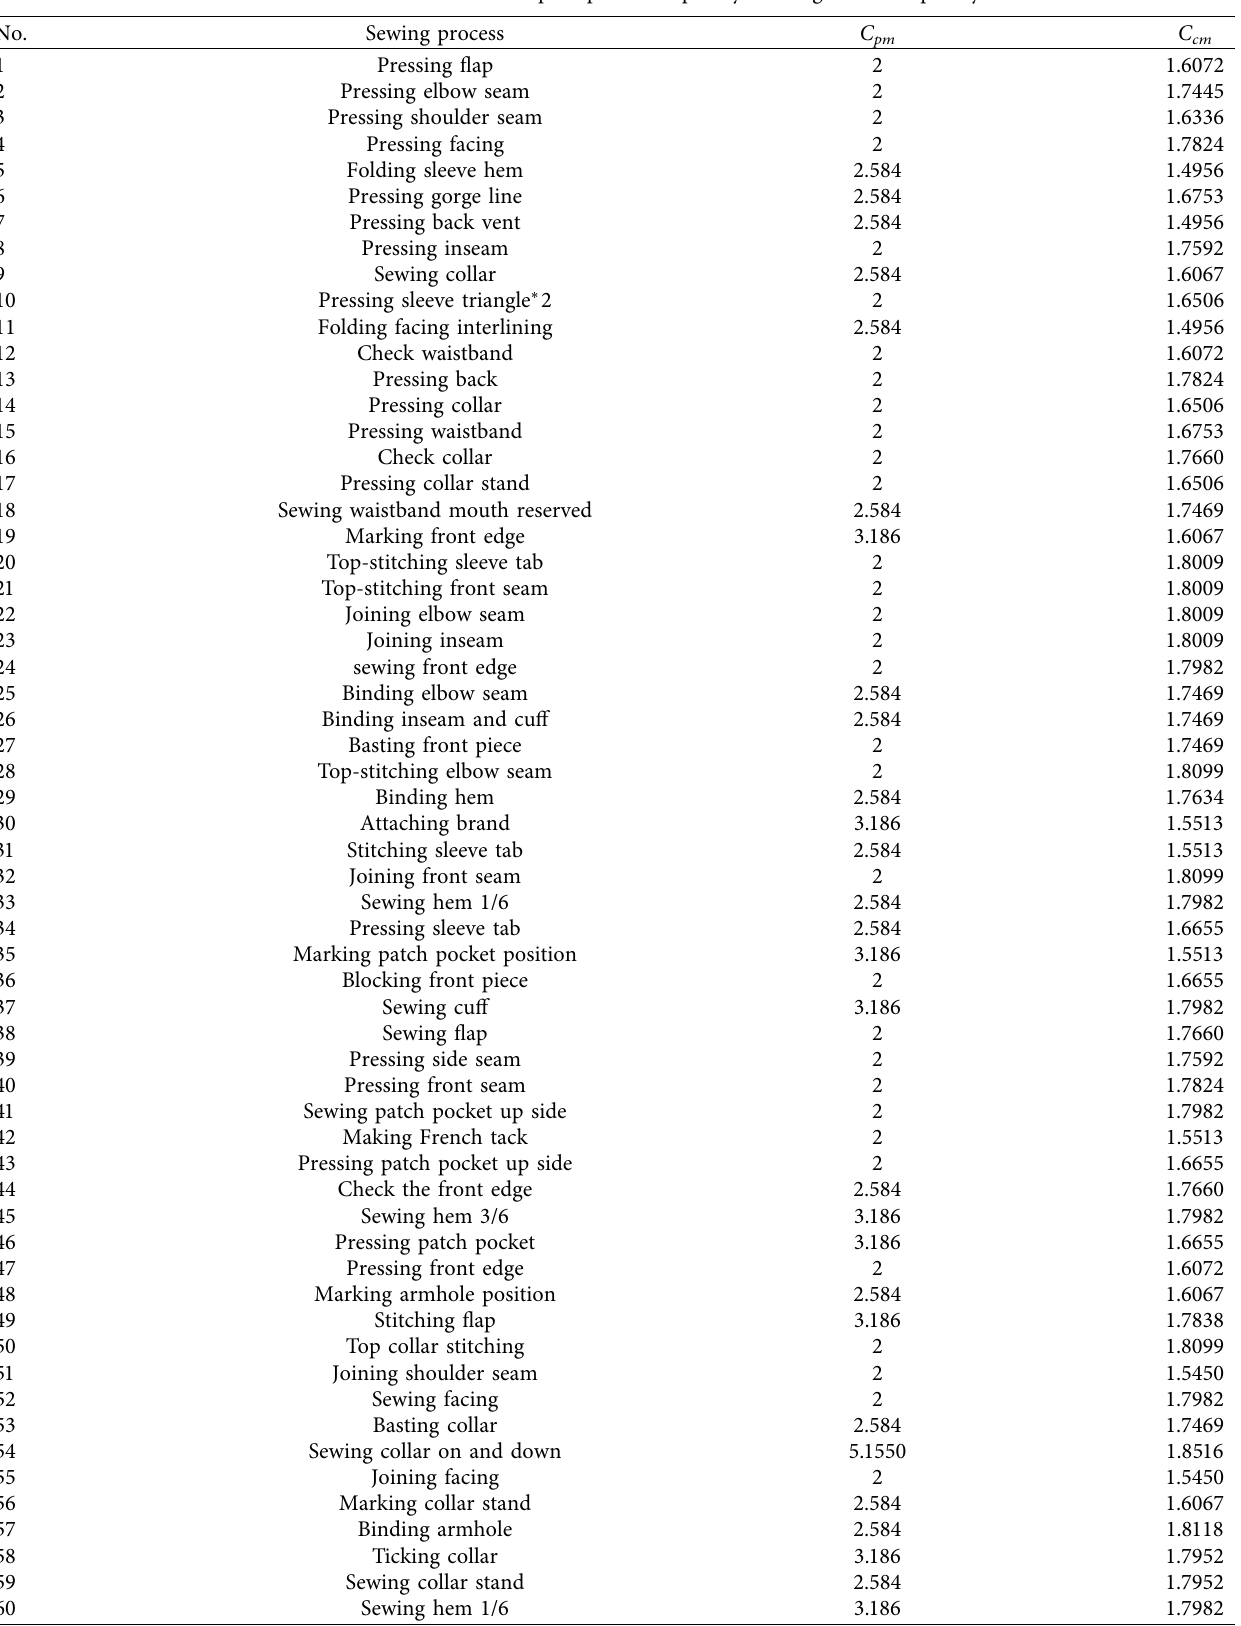
Table 12: Calculation results of perception complexity and cognitive